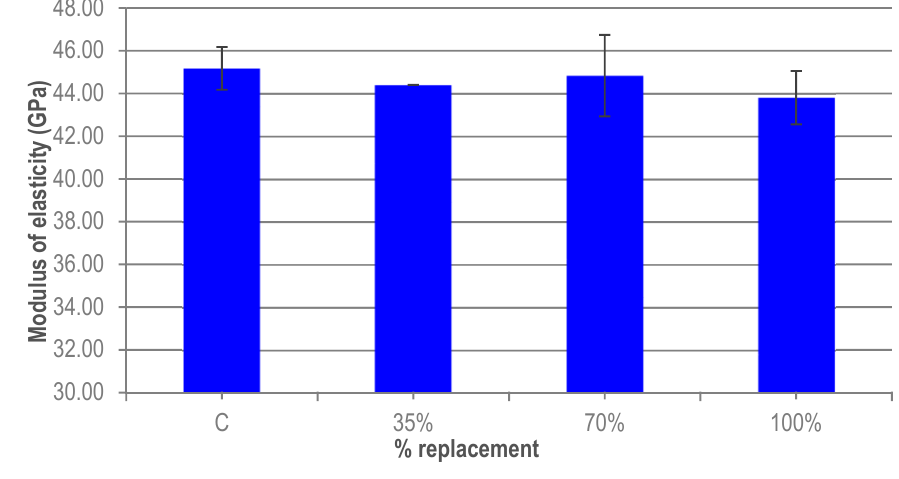
Figure 6. Modulus of elasticity of UHPC.